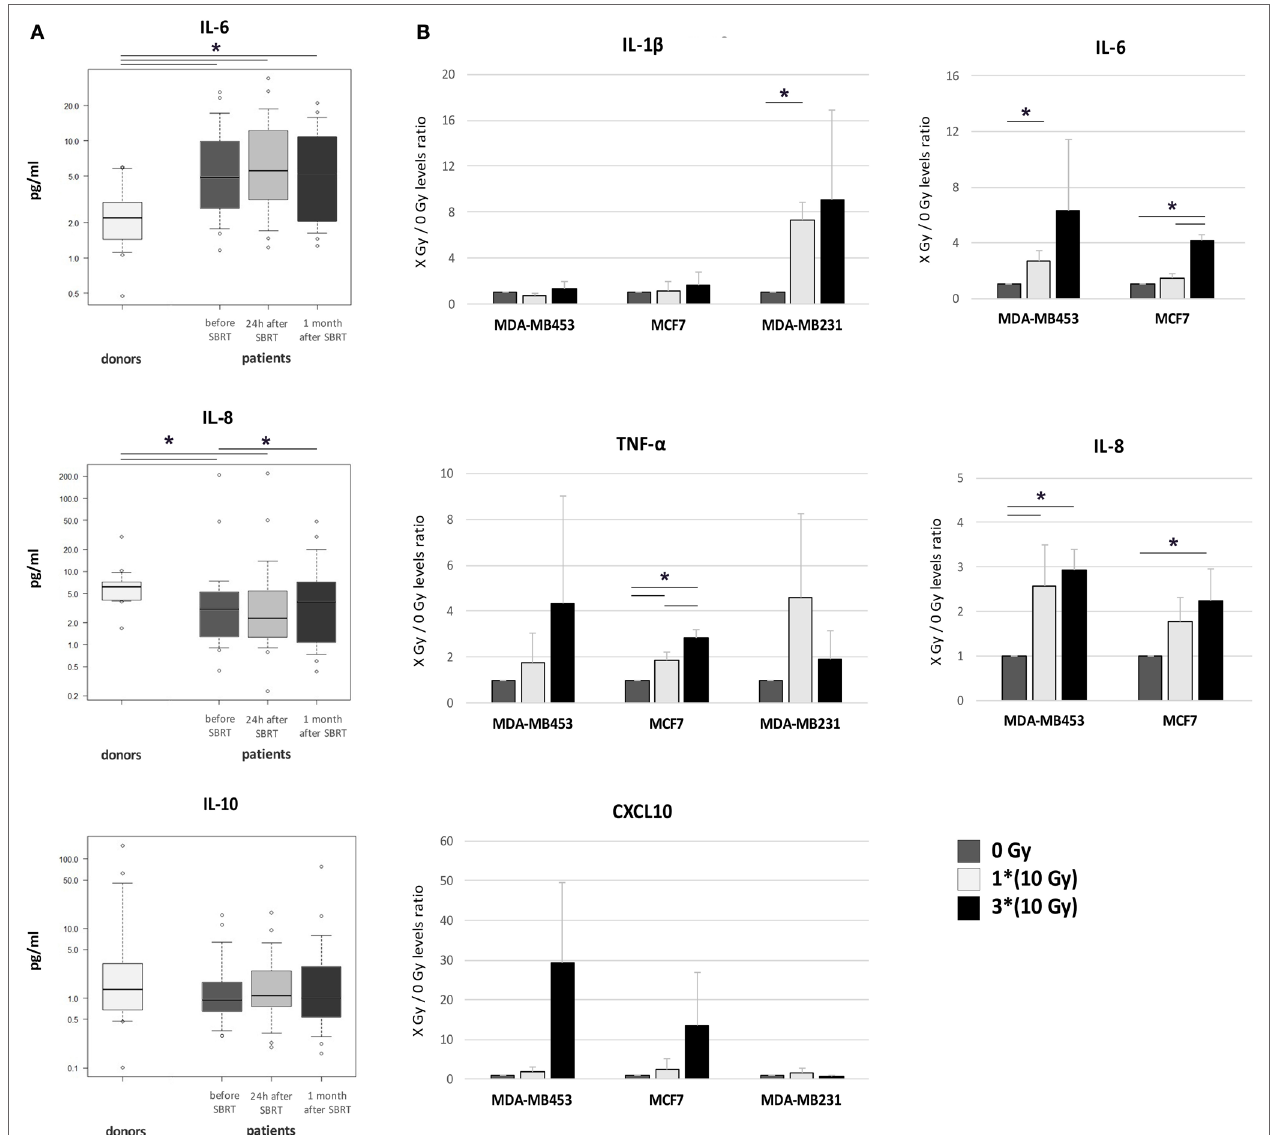
FigUre 5 | Cytokine levels in patient serum and in the supernatant of irradiated breast cancer (BC) in vitro models. (a) Serum levels of IL-6, IL-8, and IL-10 were monitored in healthy women (donors, n = 14) and in oligometastatic BC patients ( n = 21) before SBRT (dark gray), 24 h after the first SBRT fraction (light gray), and 1 month after SBRT (dark), through multiplex ELISA arrays. The values in the Y axis are reported in a logarithmic scale. (B) The amount of cytokines and chemokines released by BC in vitro models after irradiation was monitored in culture supernatant collected 72 h after treatment, through multiplex ELISA arrays. Data are represented as mean and SD of the ratios between treated (one SBRT fraction of 10 Gy, light gray; three SBRT fractions of 10 Gy, dark) and untreated samples (dark gray) measured in three independent experiments. IL-6 and IL-8 levels in MDA-MB231 were above the detection limit in all conditions (* p ≤